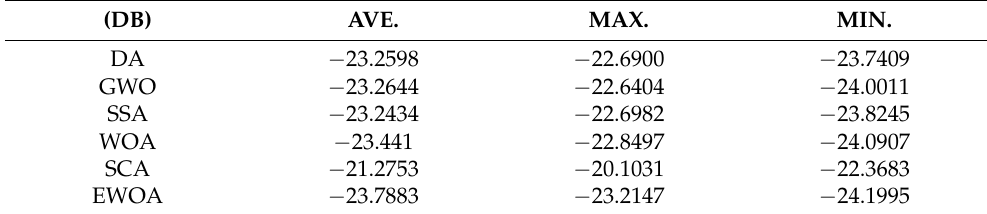
Table 1. Statistical results of the objective values obtained by different approaches. (DB) AVE. MAX. MIN. DA − 23.2598